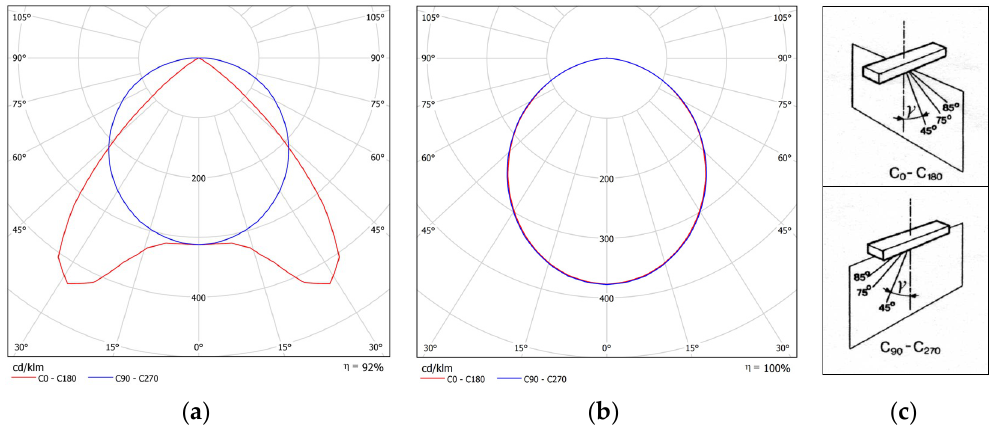
Figure 1. Light distribution of different kinds of luminaires: ( a ) conventional symmetric distribution, fluorescent or LED tubular luminaires, the red line refers to planes C0–C180, the blue line refers to planes C90–C270. Unit: cd/klm; ( b ) LED panel luminaires (right); ( c ) definition of distribution plane.